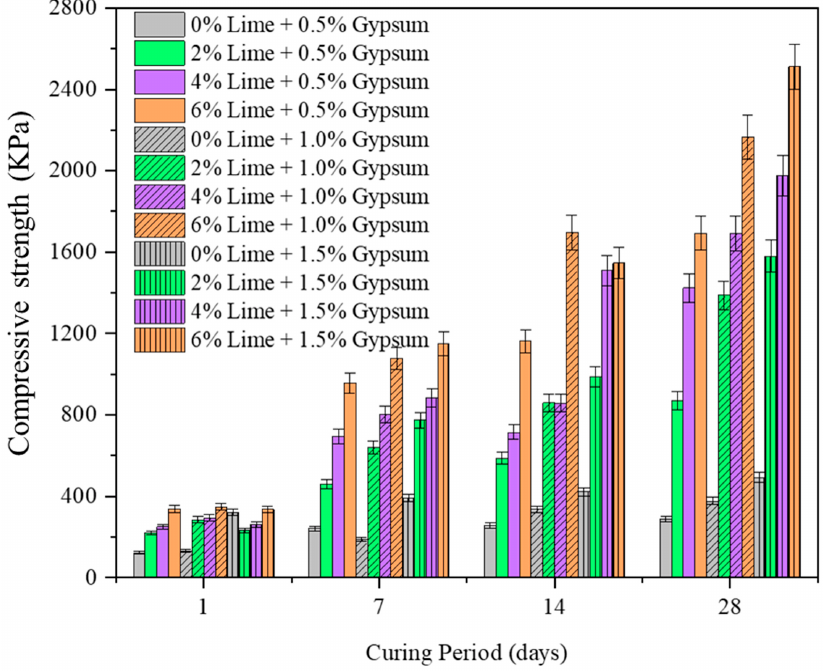
Figure 4. The variation in unconfined compression strength of coal gangue with curing period (1, 7, 14, and 28 days), lime (0 to 6%) and gypsum (0 to 1.5%)